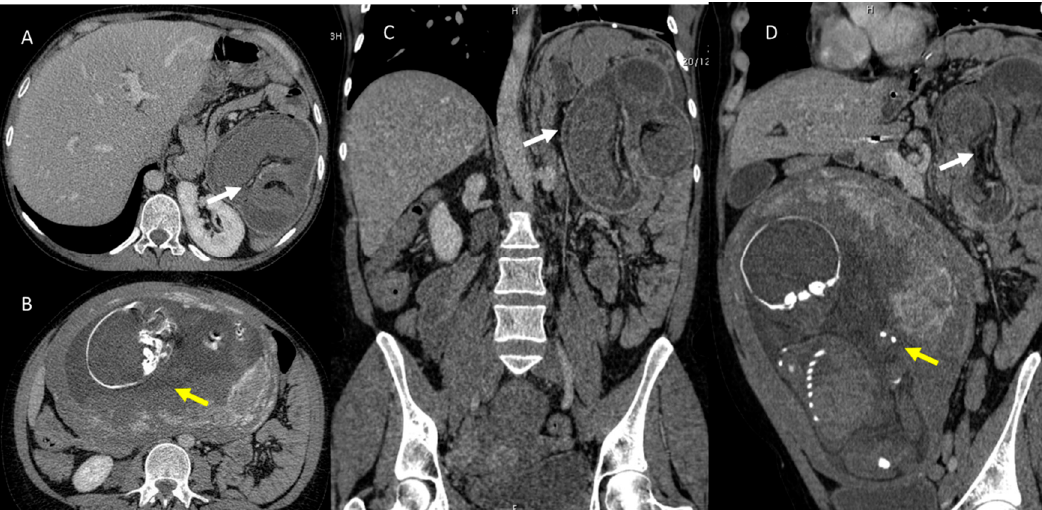
Figure 1. Pregnant woman (yellow arrows) with emergency room admission for abdominal pain, vomiting, and heart rhythm disturbances. US assessment reveals no specific findings. CT study in axial plane ( A , B ) and in coronal MPR plane ( C , D ) shows volvulus (white arrows) of the small bowel in the left epigastrium.